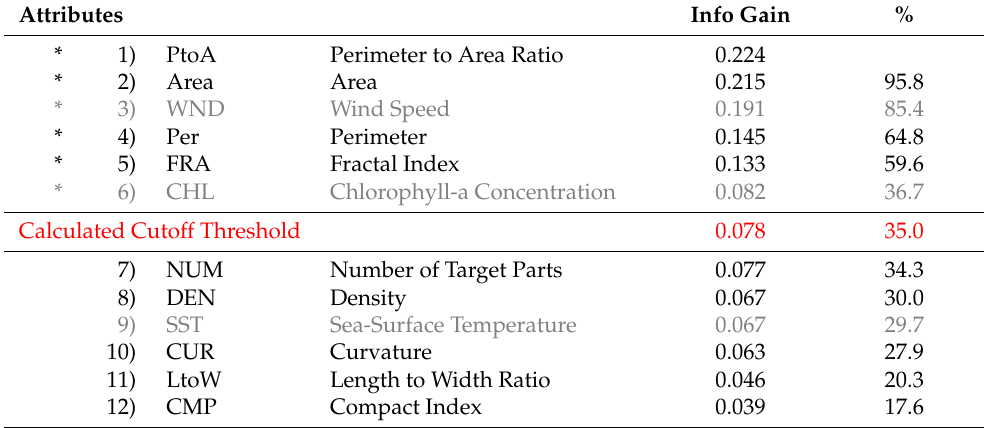
Table 2. Feature-selection ranking results (Information Gain: Info gain—Section 2.1.1) explored for the training and testing of machine-learning (ML) algorithms in our experiment. The explored variables are those from our database (769 samples from the Campos Basin, Brazil—Sections 2.2 and 2.3). The selected attributes (i.e., six “most representative” ones) are indicated with *. Color-code: black (morphological information), gray (MetOc parameters), and red (calculated cutoff threshold—see the text; Section 3.1). The relative-importance percentages (%) of each variable are shown and refer to the highest